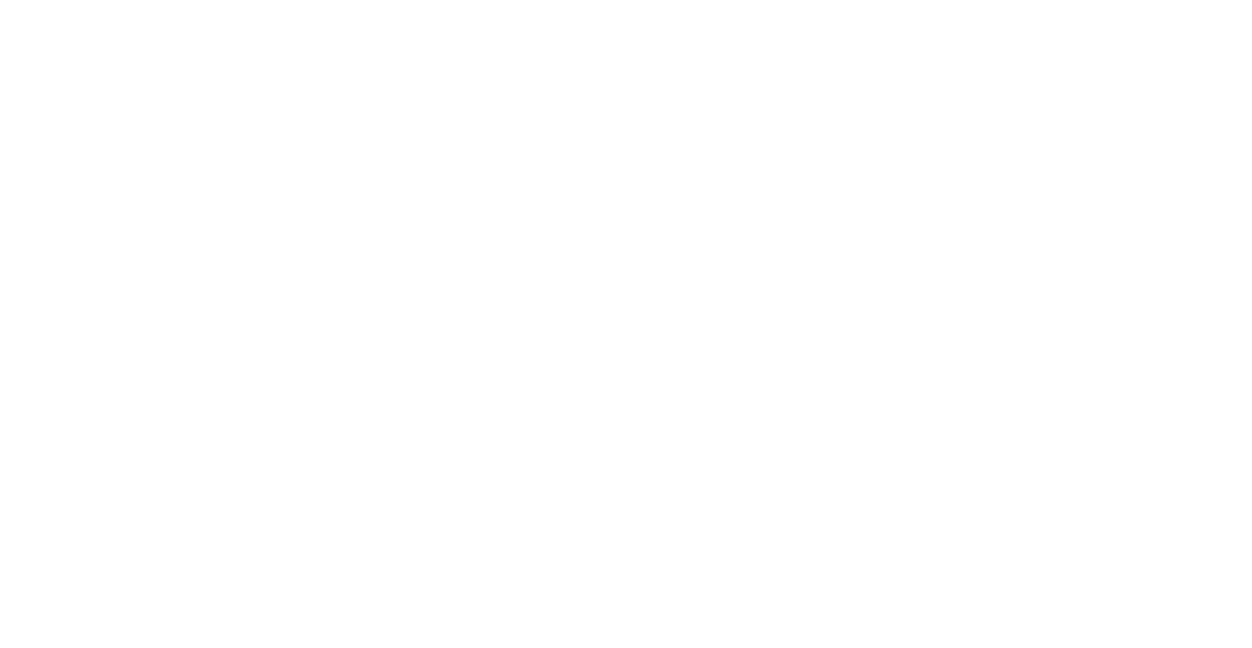
Figure A7 | Time-course of activation in face-sensitive regions for the group of normal participants in the Arcimboldo face detection task, for correct trials only. Only the right FFA and the right pSTS showed a significantly larger response to stimuli correctly detected as